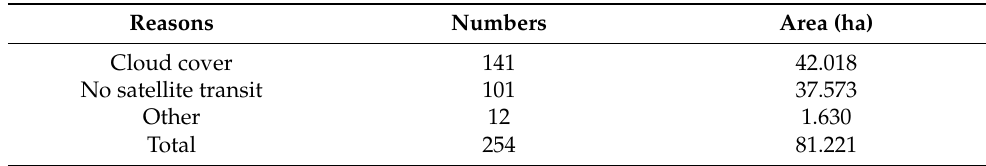
Figure 10. True color images from the time of the lightning-caused forest fires on 31 May 2018. 3.5. Discussion Currently, both domestic and foreign remote sensing satellites operate in various orbits, including geosynchronous and polar orbits, and provide Earth observation data with distinct revisit periods, spatial resolutions, coverage, and spectral characteristics. This diversity of satellite capabilities plays a crucial role in forest fire monitoring. While satellite monitoring offers significant advantages such as timeliness and accuracy, it can be impacted by weather conditions [32,33]. For instance, during a lightning strike, cloud cover may impede the satellite’s ability to monitor the fire. Heilongjiang Province, a vast forest province in China, is highly susceptible to wild- fires, especially in the Daxing’an Mountains, where thunderstorms often occur, leading to lightning-caused forest fires. During late May and early June each year, cold fronts from Lake Baikal and Mongolia converge over the Daxing’an Mountains forest area, re-